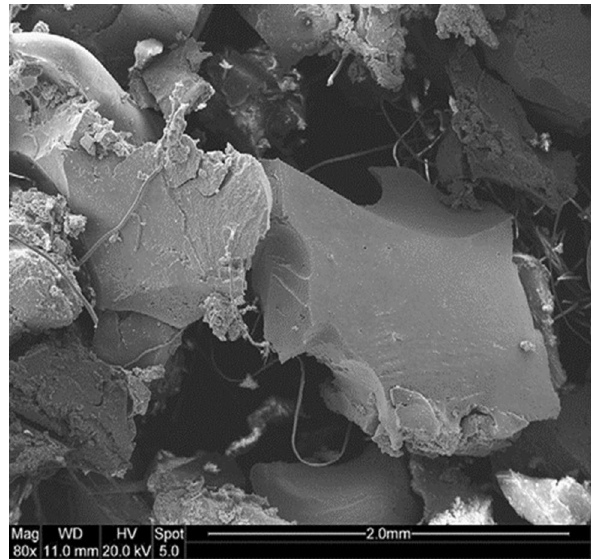
Fig. 17 80 × magnification of crumb rubber